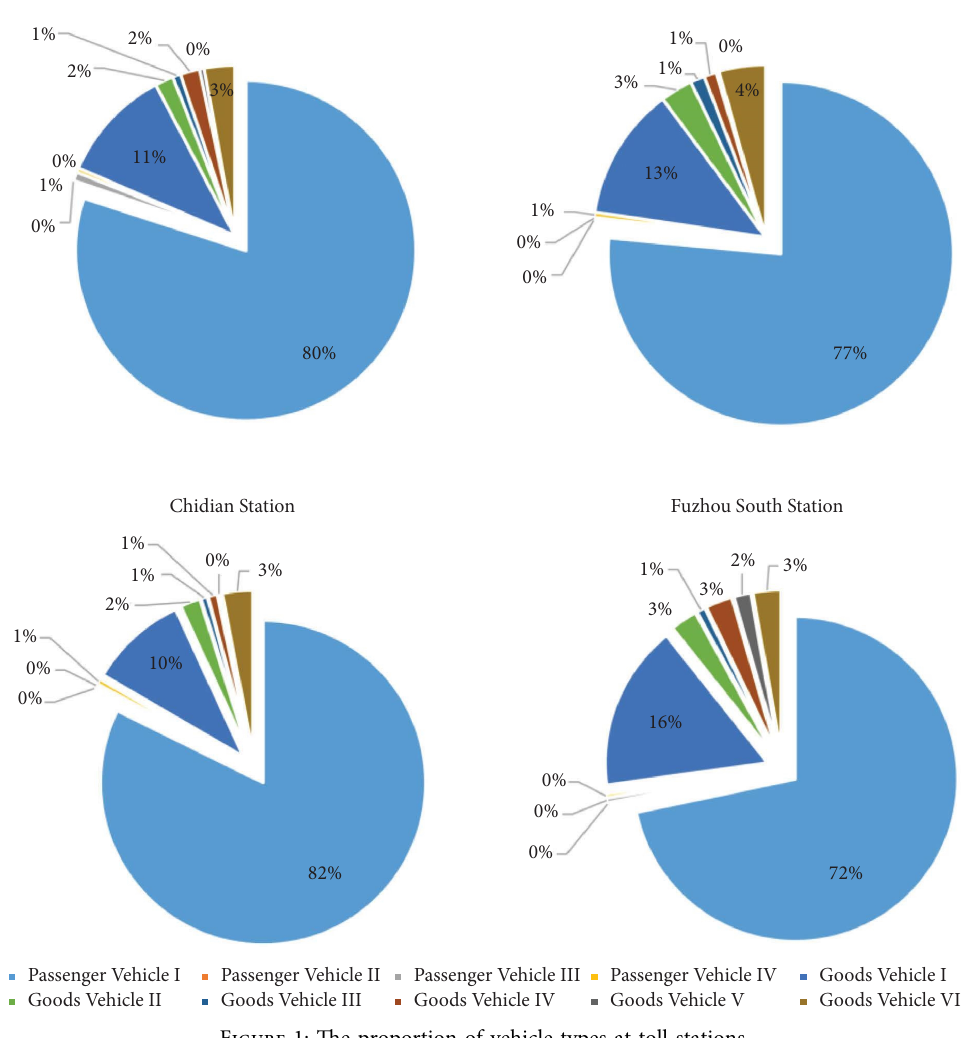
Figure 1: Te proportion of vehicle types at toll stations.